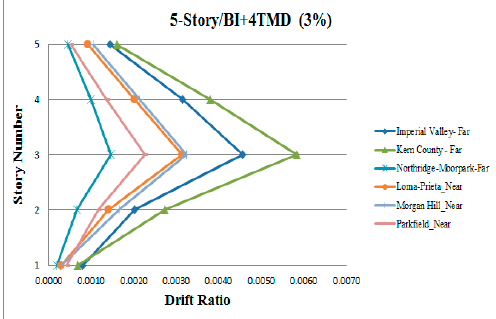
Figure A30. Drift ratios for 5-story base-isolated building with 4 TMDs.